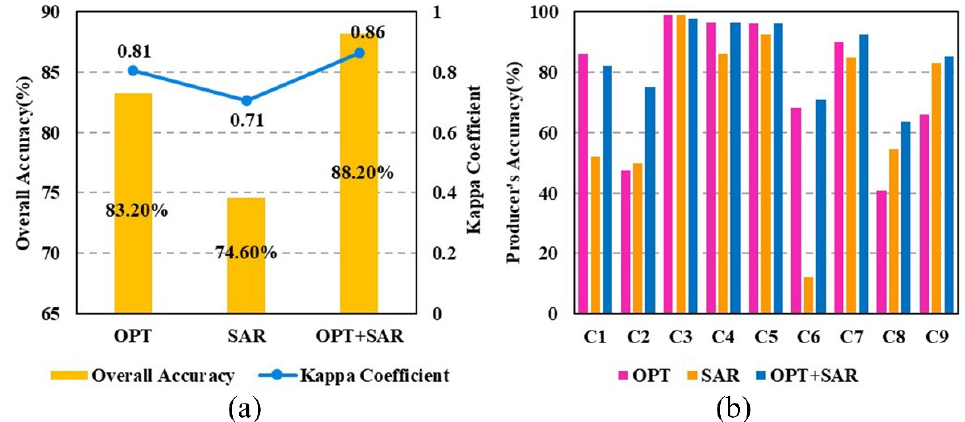
Figure 5. The classification accuracy of the OGCF model with different feature sets. Note that OPT represents the spectral feature sets extracted from optical imagery (Sentinel-2), SAR represents the polarimetric decomposition features extracted from radar imagery (Radarsat-2), and OPT + SAR represents the hybrid feature sets including spectral and polarimetric decomposition features. ( a ) The overall accuracy and kappa coefficient of the OGCF model with different feature sets. ( b ) The producer’s accuracy for each land cover by using the OGCF model with different feature sets. C1–C9 are the class codes that represent different land cover classes (see Table 2).